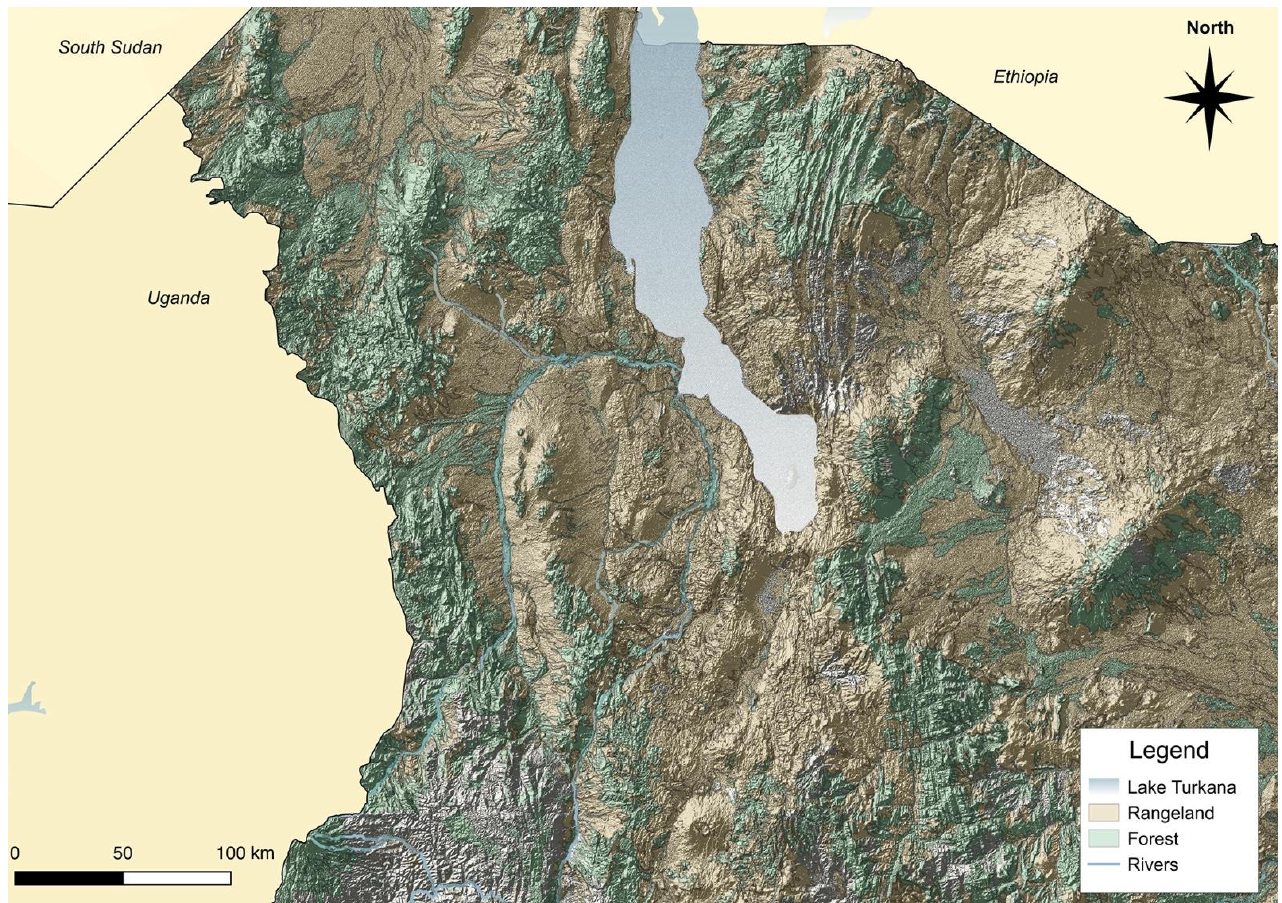
Figure 1. Topographic map of northern Kenya showing the rough distribution of forest and rangeland. Turkana County is located in the area to the west of Lake Turkana.